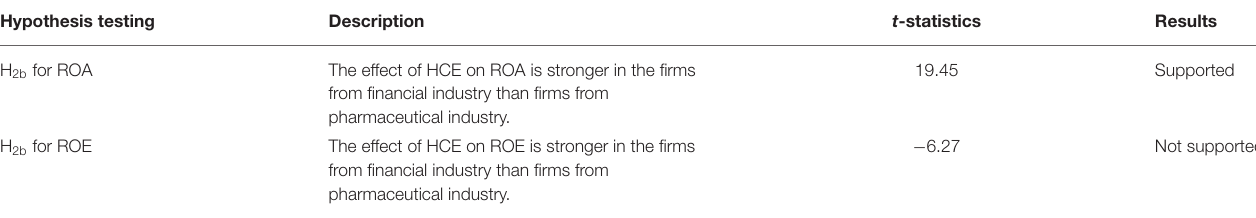
TABLE 5 | Summary of hypotheses testing results for financial and pharmaceutical industries. Hypothesis